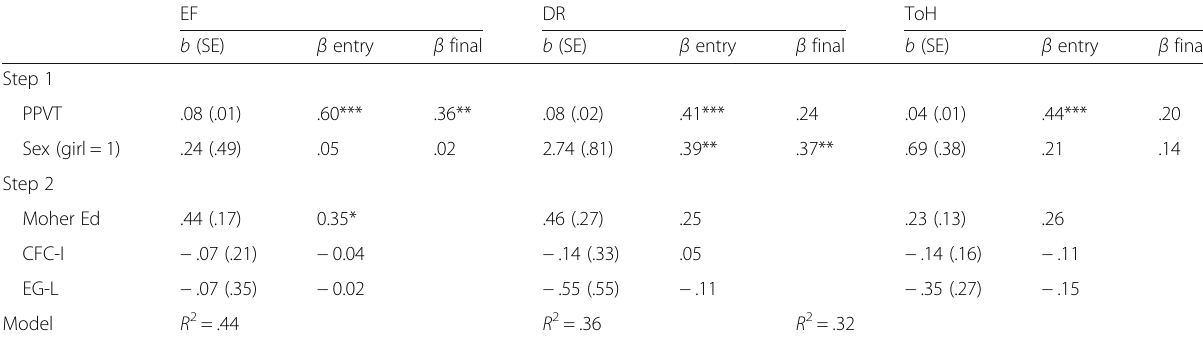
Table 3 Hierarchical linear regression with direct scores of PPVT and sex (step 1) and CFC-I and limit setting difficulties (step 2) as predictors of EF, delay reward, and Tower of Hanoi